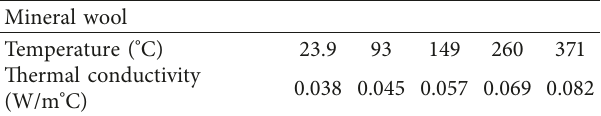
Table 1: Thermal conductivity of the mineral wool.